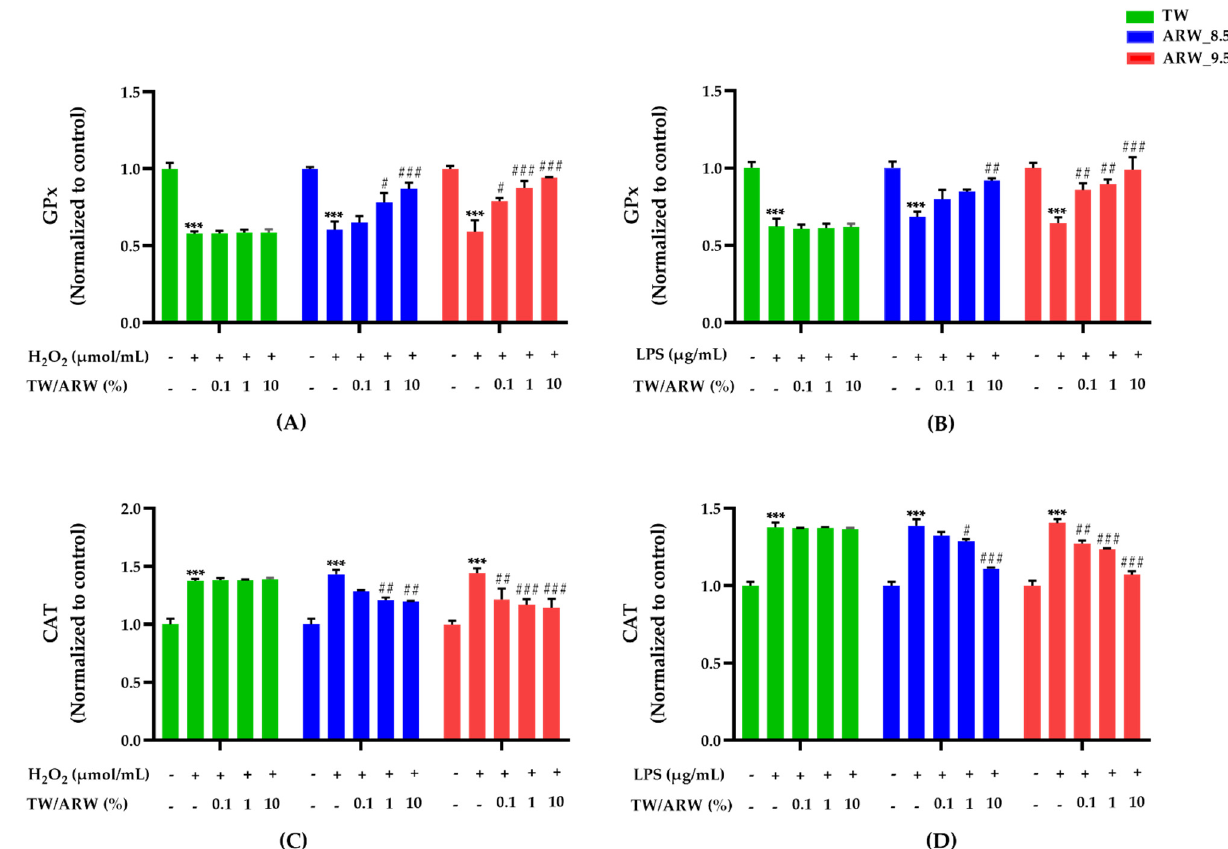
Figure 3. Effect of ARW at pH 8.5 and pH 9.5 on the activity of antioxidant enzymes (GPx and catalase) in H 2 O 2 − and LPS-induced RAW 264.7 murine macrophage cells. Cytotoxicity of cells was induced by H 2 O 2 (200 µmol/mL for 2 h) ( A , C ) and LPS (10 µg/mL for 24 h) ( B , D ), and the cells were treated with ARW (pH 8.5 and pH 9.5) at concentrations of 0.1%, 1%, and 10%. Data are expressed as the mean ± standard error of the mean (SEM) of the fold change relative to the control ( n = 3). Statistical significance was analyzed with two-way ANOVA. ( − ): non-treatment, (+): treatment. ***, p < 0.001 vs. normal control. # , p < 0.05; ## , p < 0.01, and ### , p < 0.001 vs. Con/H 2 O 2 or Con/LPS. Abbreviations: ARW, alkaline reduced water; TW, tap water; H 2 O 2 , hydrogen peroxide; LPS, lipopolysaccharide; GPx, glutathione peroxide; Con, control